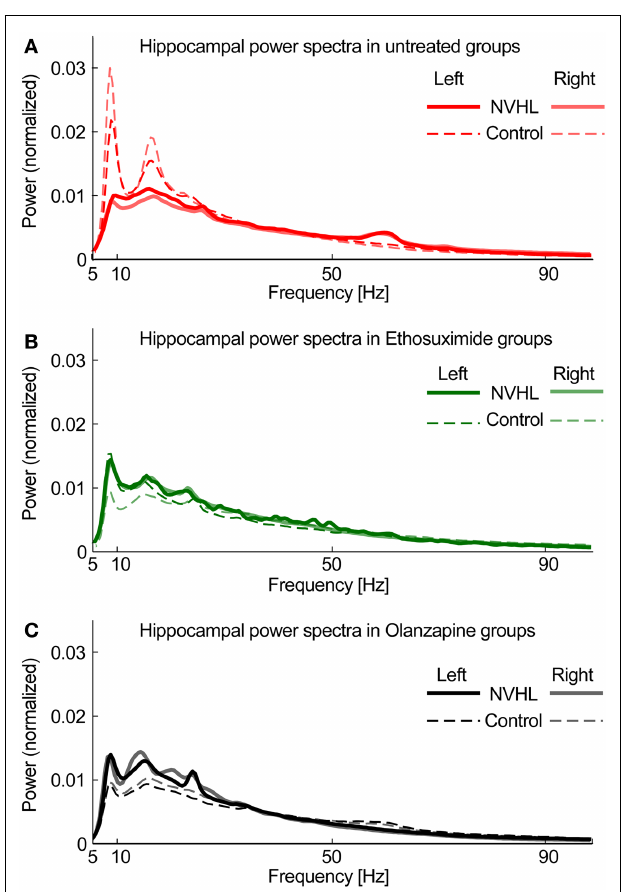
FIGURE 1 | Hippocampal power spectra . (A) Power spectra density plot for untreated groups averaged across all subjects for NVHL (thick line) and control (thin line) computed independently for left (opaque line) and right (semi-transparent line) hippocampi. (B) Power spectral density plot for Ethosuximide-treated animals. (C) Power spectra density plot for Olanzapine-treated animals.The similarities between the corresponding left and right spectra is a common observation, is independent of phase synchrony, and is only indirectly related to neural coordination in that neural oscillations are the fundamental, unitary components of neural coordination processes such as phase synchrony and cross-frequency coupling (30).